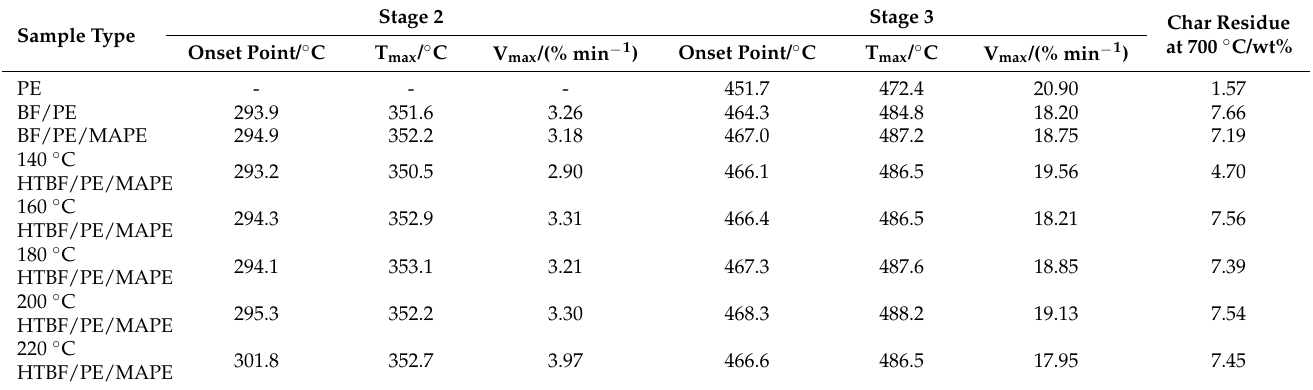
Table 6. Decomposition characteristic parameters of PE and bamboo fiber/PE composites.